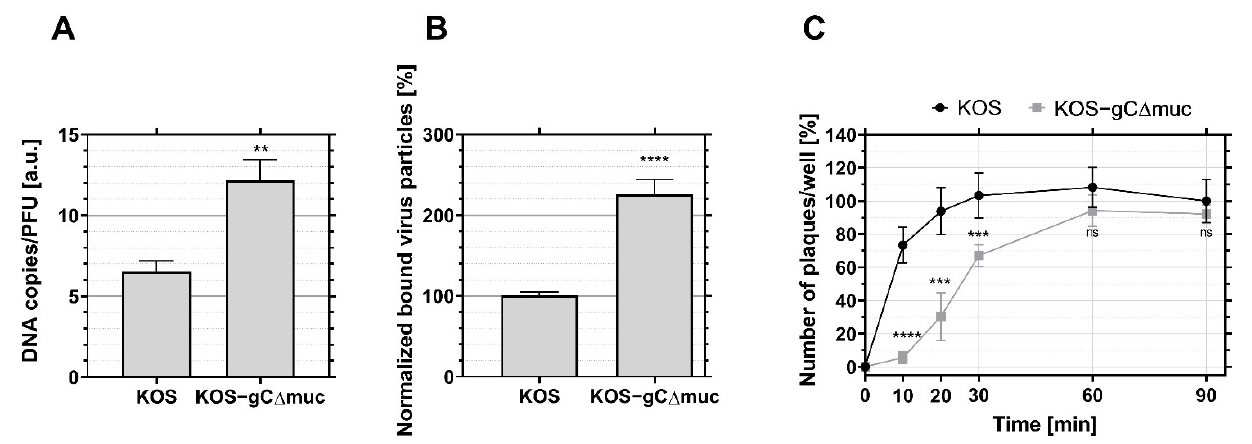
Figure 5. Influence of the mucin-like (MLD) domain of the glycoprotein gC on HSV-1 binding and entry kinetics into HaCaT cells. ( A ) DNA copies/PFU ratio for KOS and KOS-gC Δ muc. ( B ) Binding of wild type (KOS) and MLD-deleted (KOS-gC Δ muc) HSV-1 to HaCaT cells at the same concentration of infectious particles. The total number of particles bound in terms of DNA copies was estimated by qPCR. ( C ) Wild-type (KOS) and MLD-deleted (KOS-gC Δ muc) were added to HaCaT cells at equal concentrations of infectious particles (200 PFU/mL) and entry quantified at differenttime points. The number of plaques was normalized to the value for KOS at 90 min. Student’s t -test was used to assess the significance, ns = not significant, ** p ≤ 0.01, *** p ≤ 0.001 and **** p ≤ 0.0001 relative to the control HaCaT cells.